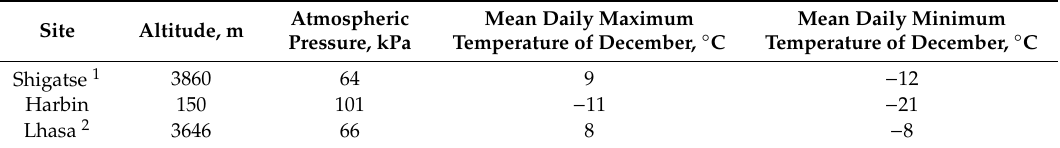
Table 1. Natural environment of test